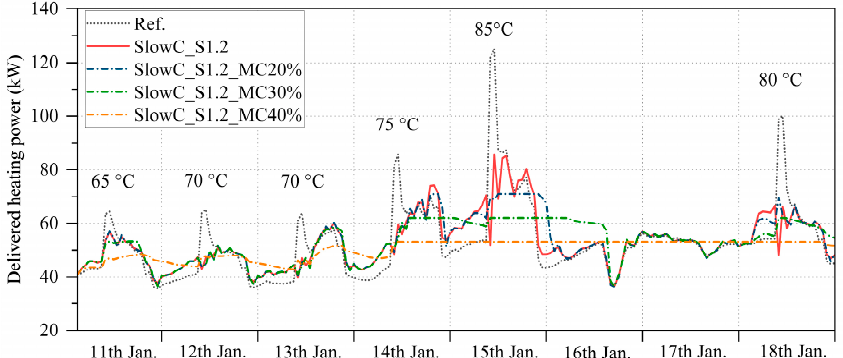
Figure 11. Delivered heating power with mass flow cutting and different maximum charging water temperature setpoints ( T set,max ) of a period in January.